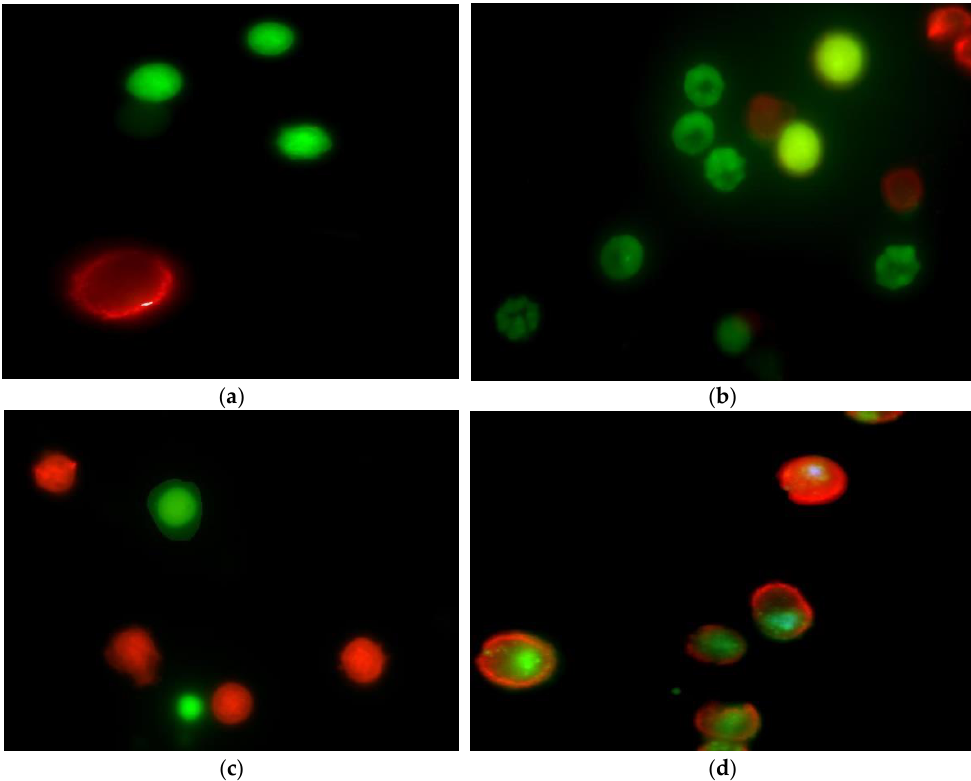
Figure 2. Apoptosis induced by CLB and VPA in CLL cells. The photos show apoptotic cells after 24 h of incubation under the fluorescence microscope with magnification 1500×: live cells stained with 6-CF (green), necrotic cells stained with AnnCy3 (red), and cells starting the apoptotic process stained with both AnnCy3 and 6-CF. ( a ) CLL cells cultured without drugs as a negative control, ( b ) CLL cells cultured with combination of CLB (17.5 µ M) and VPA (0.5 mM), ( c ) CLL cells cultured with CLB alone (17.5 µ M) and ( d ) CLL cells cultured with VPA alone (0.5